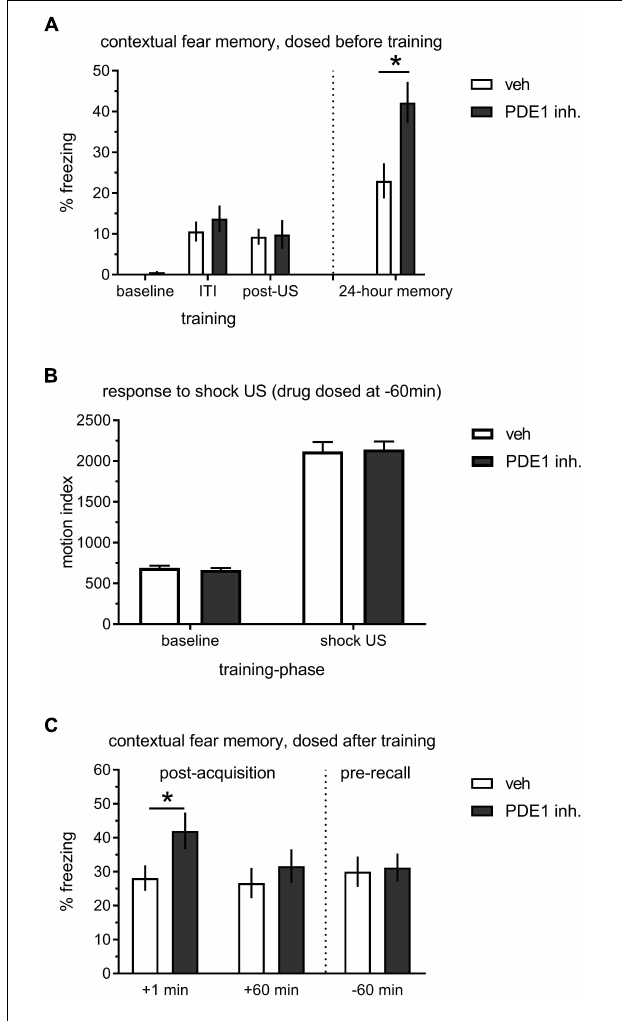
FIGURE 3 | Effect of the PDE1 inhibitor DNS-0056 on acquisition, consolidation, and retrieval of contextual memory in rats. (A) 2 × trial training 60 min after p.o. administration of DNS-0056 ( n = 32) or vehicle ( n = 32), and subsequent 24-h memory test. DNS-0056 did not affect freezing during the acquisition of contextual fear, but significant enhancement was seen in the long-term memory test. (B) Response to foot-shock during cFC training, 60 min after a p.o. dose of DNS-0056. The drug did not affect baseline motion or shock US perception. (C) Post-trial dosing of DNS-0056 or vehicle. Freezing during the 24-h retention test is shown ( n = 32 per group/time-point). Drug dosed immediately after training significantly enhanced 24-h retention of contextual fear, but no effect was seen when drug was dosed either 60 min after training, or 60 min before the memory test on day two. Mean ± s.e.m. are shown. Significant differences from vehicle control are indicated by an asterisk ( ∗